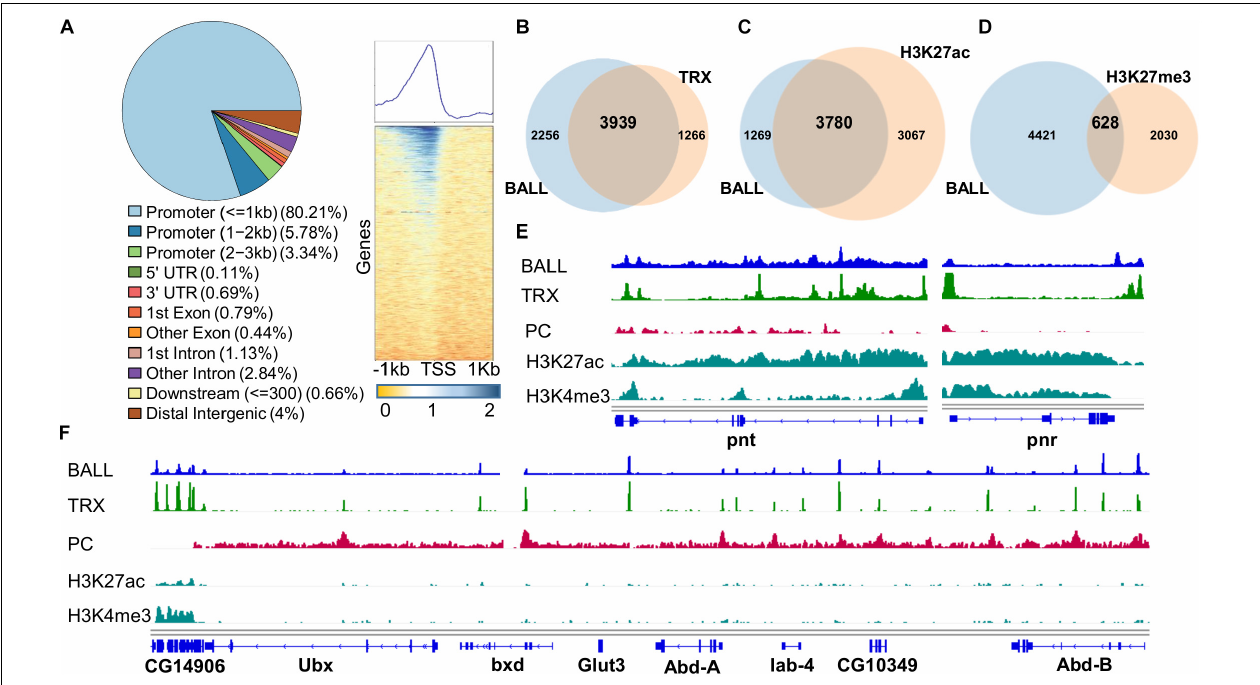
FIGURE 4 | Genome-wide binding profile of BALL analyzed by ChIP-seq from Drosophila S2 cells. (A) ChIPseeker was utilized to generate a pie chart that represents distribution of BALL across different regions of the genome. BALL is enriched predominantly in promoter (=1 kb) regions followed by promoter (1–2 kb) regions, distal intergenic regions and promoter (2–3 kb) regions. Heat map [ (A) , right panel] shows enrichment of BALL within 1 kb upstream of TSS of genes across the genome correlating with 80% occupancy of BALL in the promoter regions as shown in pie chart. (B–D) Lists of associated annotated peaks were generated for comparative analysis shown by Venn diagram analyses which show co-occupancy of BALL on known TRX peaks (B) and association of BALL with H3K27ac (C) and H3K27me3 (D) marked genes. (E) Genome Browser view of BALL enrichment compared to that of TRX, PC, H3K27ac, and H3K4me3 at pnt and pnr genes. (F) Genome Browser view of ChIP-seq data showing binding profile of BALL and its comparison with TRX, PC, H3K27ac, and H3K4me3 across the bithorax complex (BX-C). Highly enriched BALL and TRX correlates with high levels of both H3K27ac and H3K4me3 and absence of PC at CG14906 , a gene present just downstream of Ubx . In contrast, PC is highly enriched throughout BX-C locus justifying the silenced state of Ubx , abd-A , and Abd-B genes in Drosophila S2 cells. Both BALL and TRX are present at few overlapping binding sites in